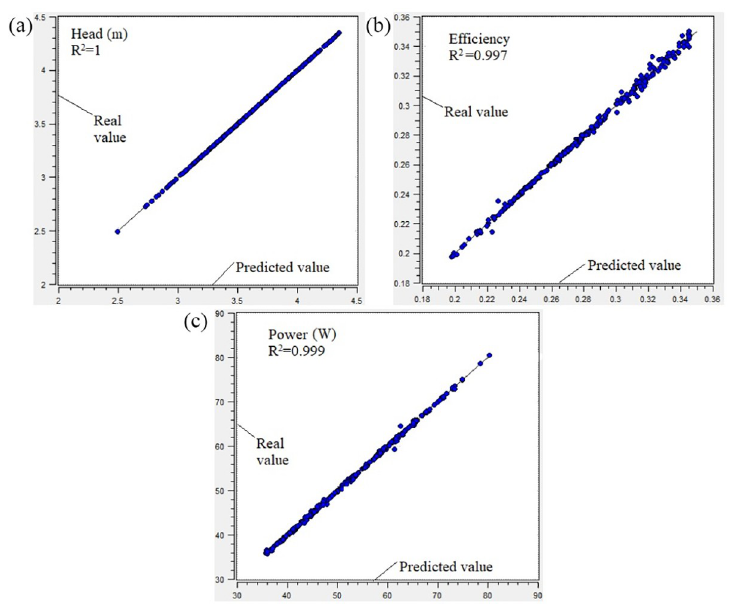
Fig 7. Prediction accuracy of optimization model: (a) head; (b) efficiency; (c) power.